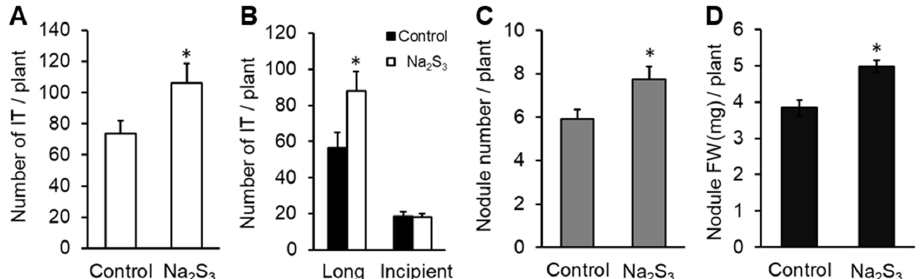
Figure 5. Effect of Na 2 S 3 on infection threads (ITs) and nodules. Na 2 S 3 was added every 72 h during the first 10 days after inoculation of Mesorhizobium loti . ( A ) Total number of ITs. ( B ) Numbers of long or incipient ITs counted at 10 dpi. ( C ) Nodule number and ( D ) nodule fresh weight (mg) per plant were measured at 1 month post inoculation (mpi). L. japonicus B-129 was used as a host plant. Values are shown as means ± SE; n = 24 for number of infection threads and n = 18 for number and fresh weight of nodules. Asterisks denote statistically significant di ff erences compared to controls (Student’s t -test, * p <